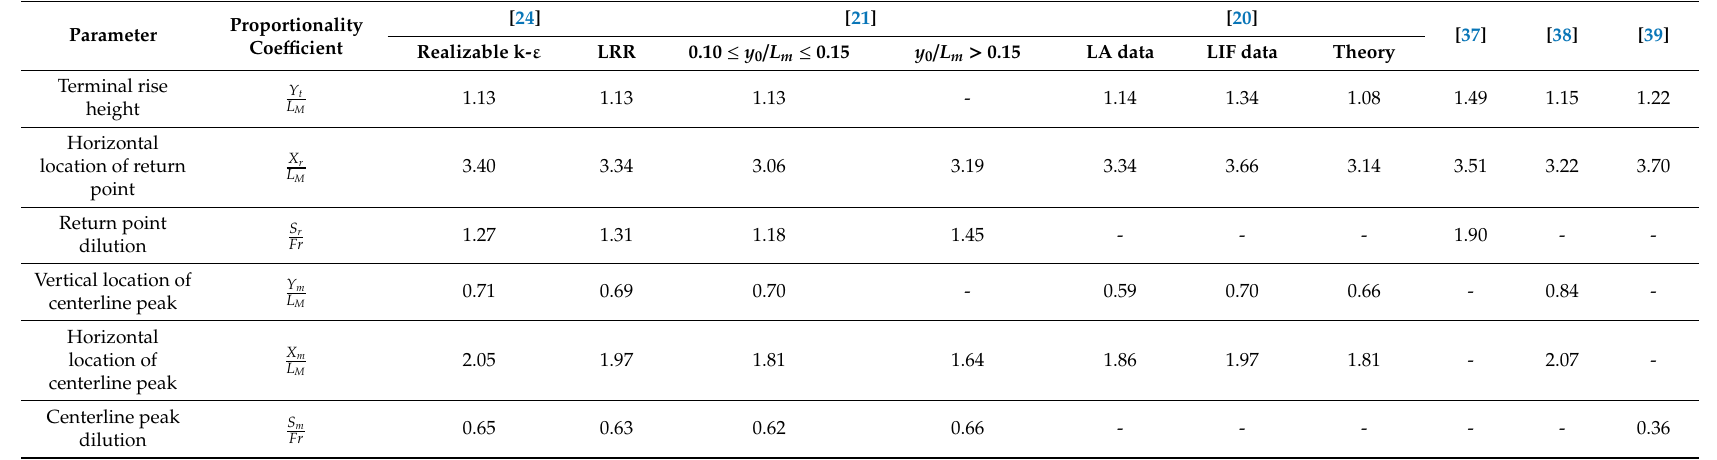
Table 2. Comparison of numerical and experimental coe ffi cients for the 30 ◦ inclined jets (Source: [24]). LIF: Laser-Induced Fluorescence, LRR: Launder-Reece-Rodi.